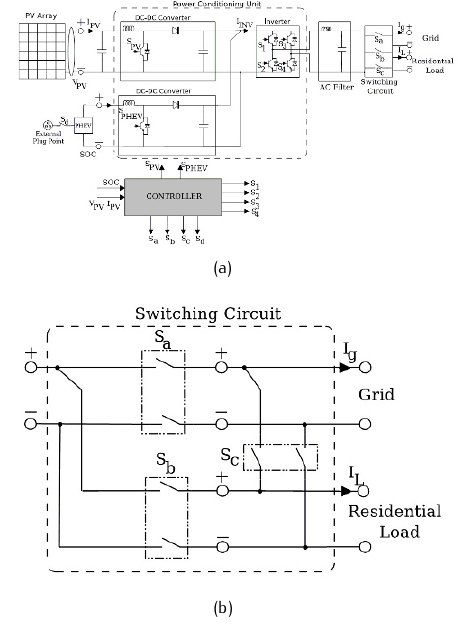
Figure 2. (a) Detailed view of PCU. (b) Switching circuit